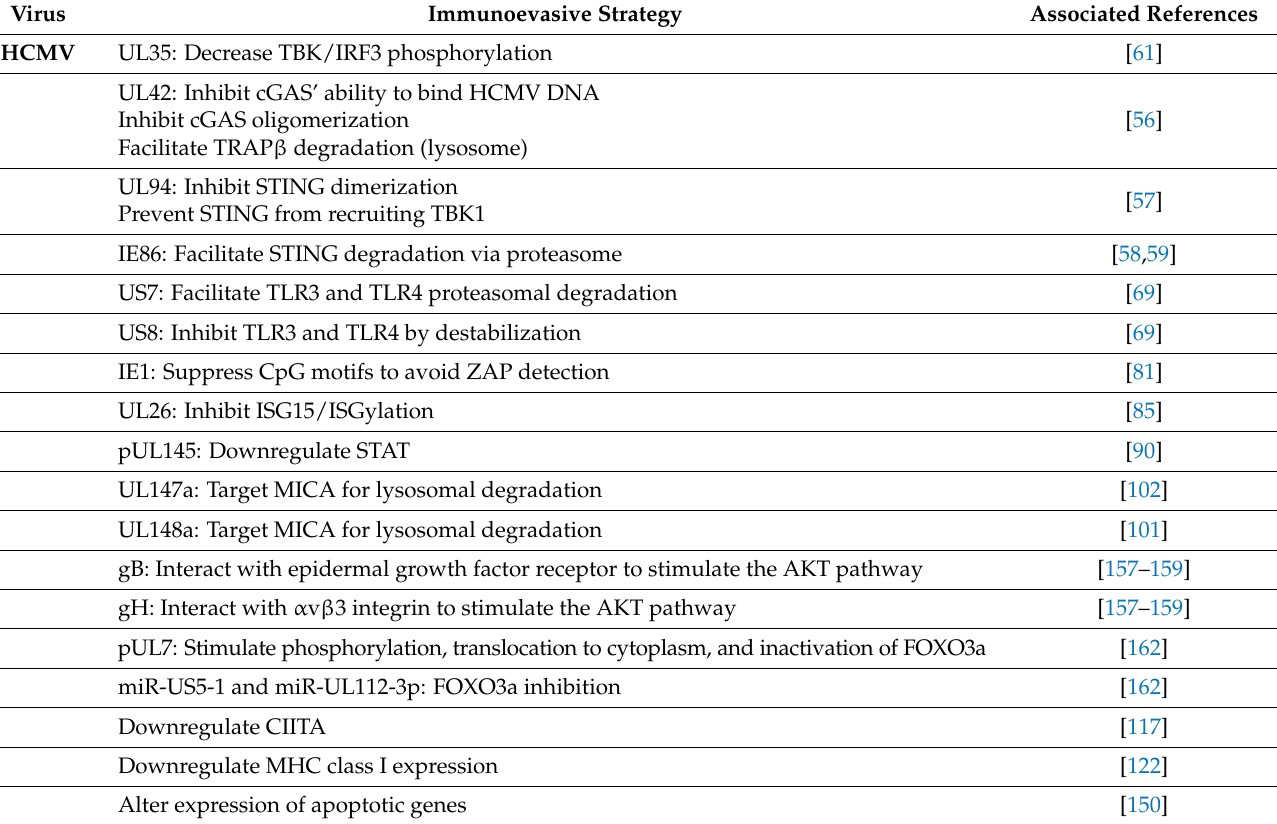
Table 1. Summary of Betaherpesvirus Immunoevasive